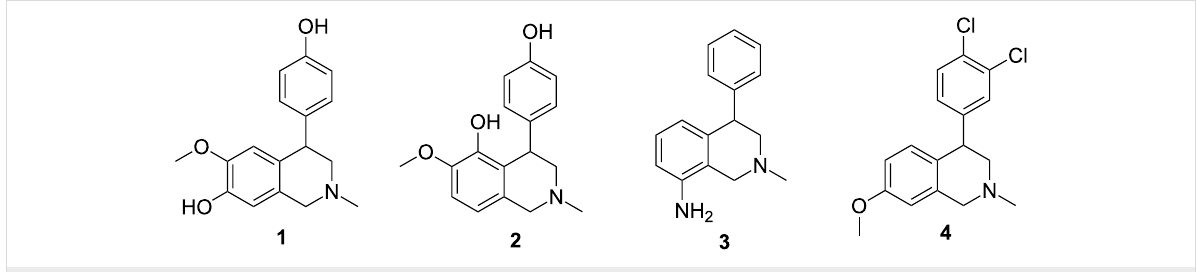
Figure 1: Aryl-1,2,3,4-tetrahydroisoquinolines.